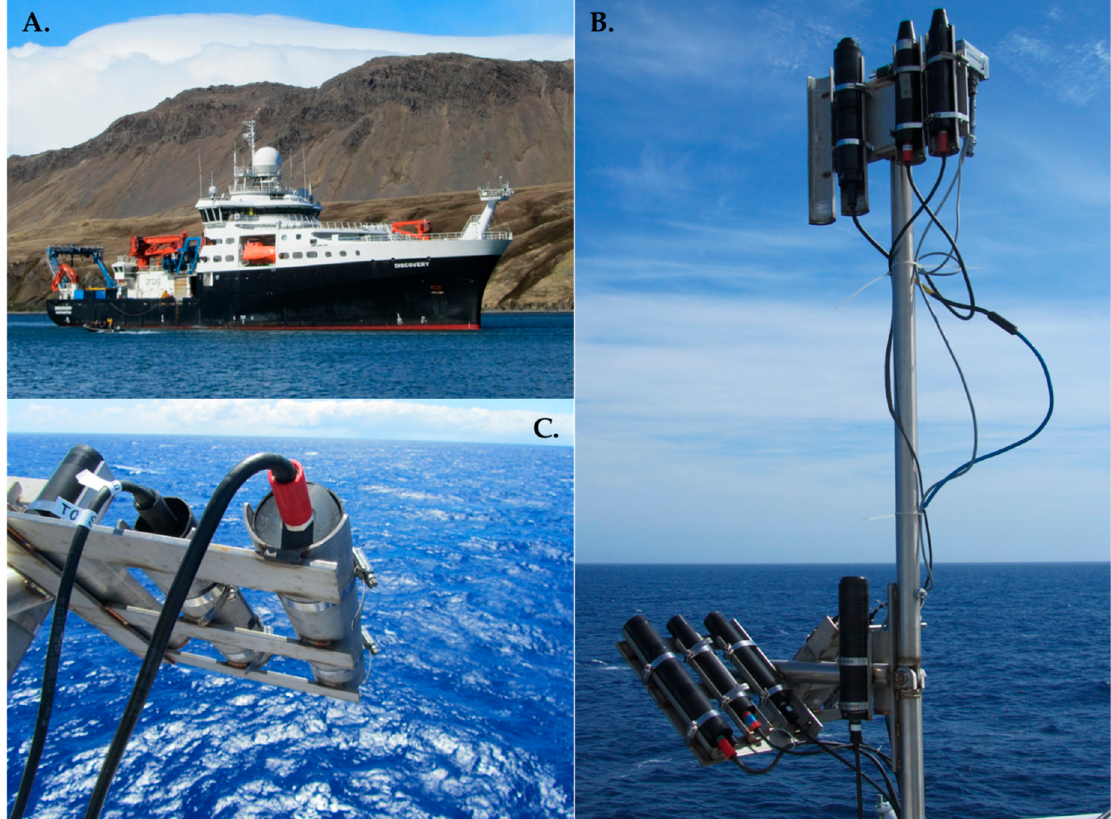
Figure 1. Radiometer set up on RRS Discovery ; ( A ) showing the location of the meteorological mast on the bow of the ship where the radiometers were located; ( B ) Purpose-built frame for locating the sensors, side by side; ( C ) View of upwelling radiance sensors.